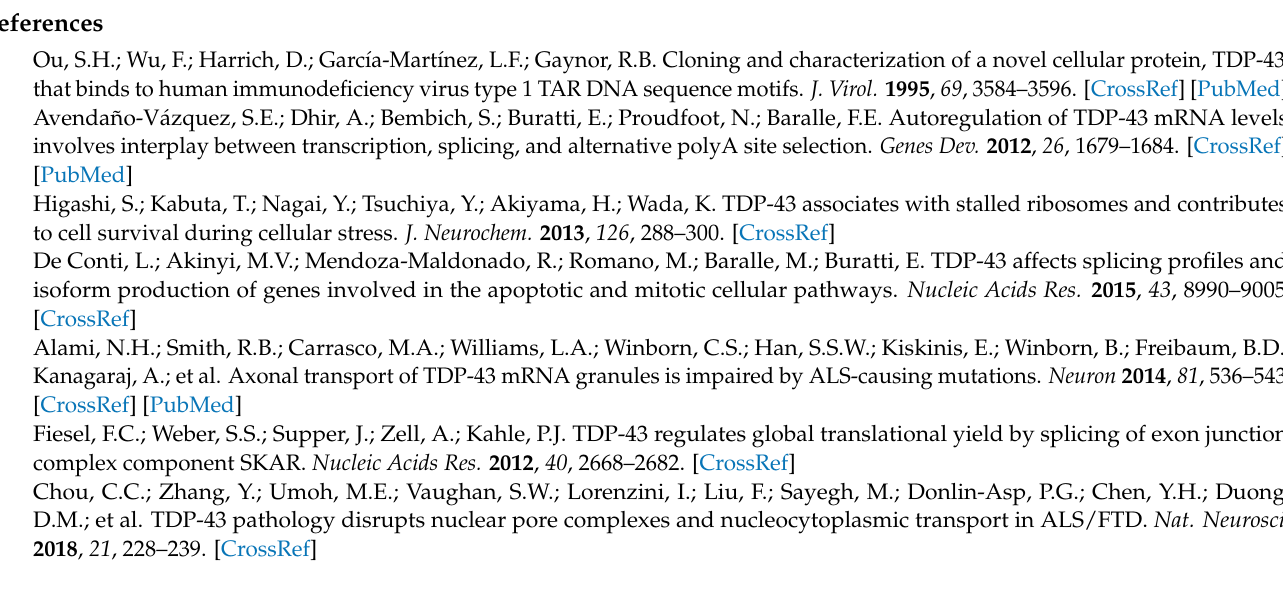
Table 1. Cont. Virus Brain Involvement HERV endogenous expression can be induced by viral RNAs and proteins, following infection of HIV-1, HBV and influenza Human endogenous A viruses [56,160]. Interestingly, increased HERV-K expression retroviruses (HERV) has been detected in brain of ALS patients, and it was found to induce neuronal injury in a model of transgenic animals [56]. Impairment of neuronal structures has been observed to occur Hepatitis B virus (HBV) in HBV-positive individuals with associated chronic liver dysfunction [161]. Cognitive dysfunctions and encephalitis were reported in Severe acute respiratory patients suffering from SAR-CoV-2 infection [162,163]. syndrome coronavirus 2 SARS-CoV-2 has been proposed to induce morphological and (SARS-CoV-2) cellular alteration of brain structures [162]. WNV causes severe neurological illness, generally referred to West Nile neuroinvasive disease (WNND) and including West Nile encephalitis (WNE), West Nile meningitis (WNM), and West Nile paralysis (WNP) [164]. West Nile virus (WNV) WNV infection has been linked to neuronal dysfunction, loss of synapses, and astrocytic gliosis, both in human patients and animal models [165–168]. Herpes simplex virus-2 HSV-2 has been observed to cause neurological complication (HSV-2) and establishes latent infection in neurons of ganglia